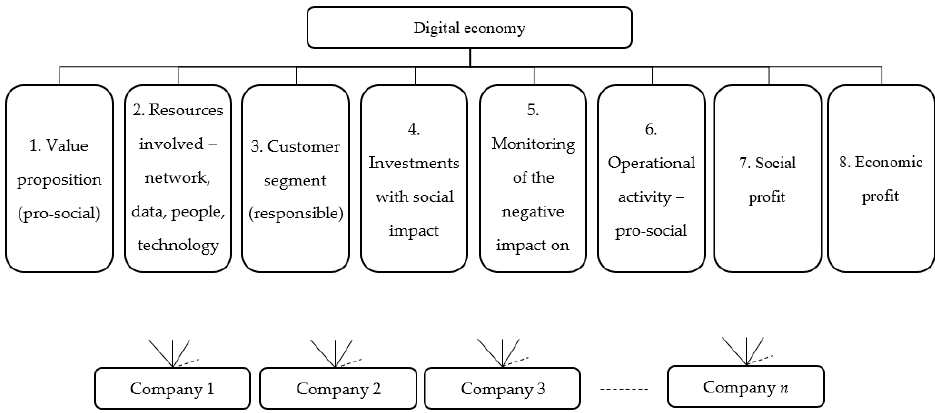
Figure 2. Diagram of a hierarchical model adopted for the research (Own study based on [52]).